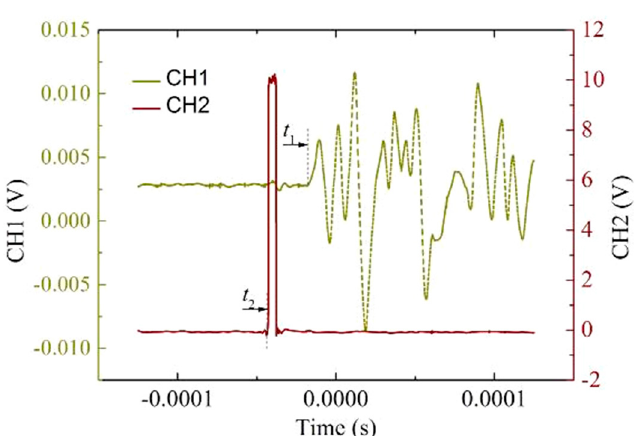
Figure 5. Response signal.